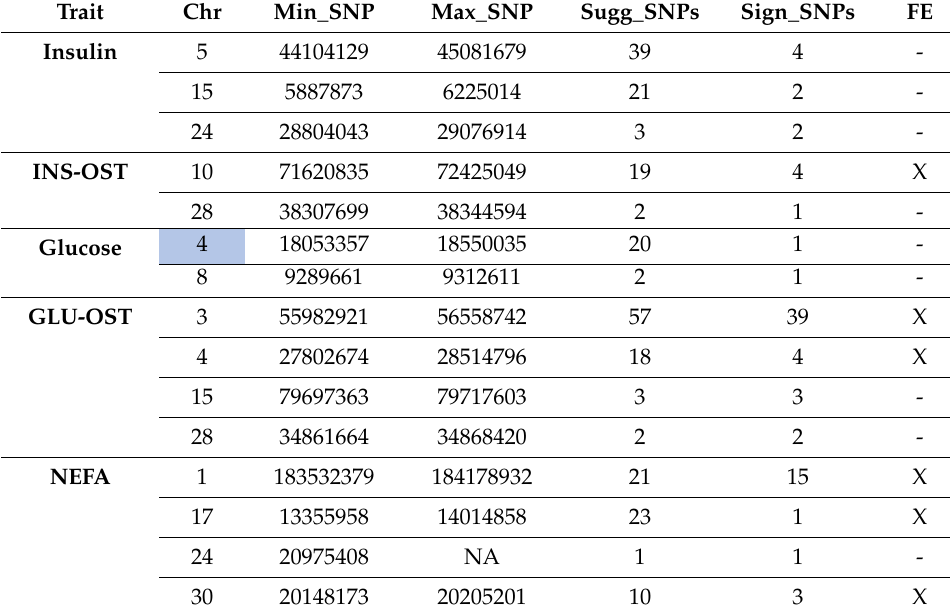
Figure 2. Manhattan plots of the genome ‐ wide association results for insulin concentration post oral sugar test in ( A ) Morgan horses and ( B ) the section A and B Welsh ponies. The equine chromosomes (ECA) are plotted on the x ‐ axis and the − log of the p ‐ value is plotted on the y ‐ axis. The blue line indicates the suggestive threshold (1.0e − 05) and the red line represents the genome ‐ wide significant threshold (7.61e − 08 in the Morgan horses and 5.98e − 08 the Welsh ponies). In the section A, B, C and D Welsh ponies (not shown) and A and B Welsh ponies (B), the same region on ECA10 exceeds the suggestive threshold, which was also identified as an ROI in the Morgan horses (A). GWA meta ‐ analysis identified this region as shared across both breeds. Table 1. Meta ‐ analysis across breeds and across EMS metabolic traits.